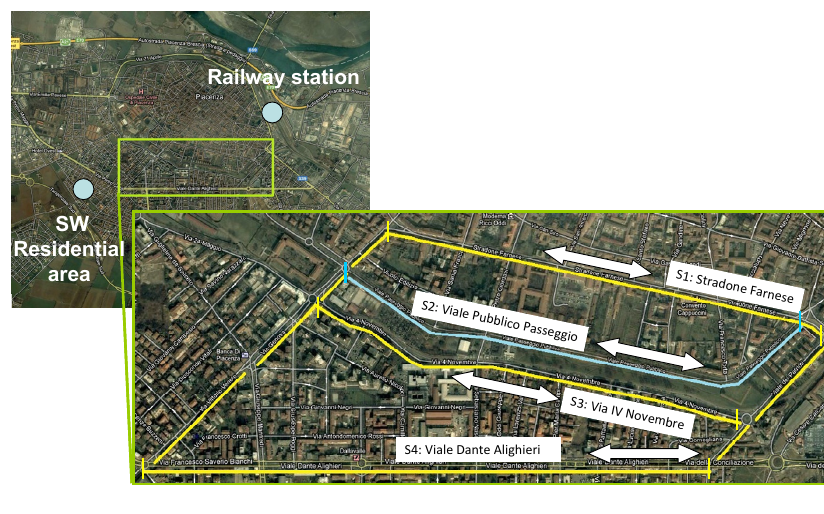
Figure 2. Selected route sectors.